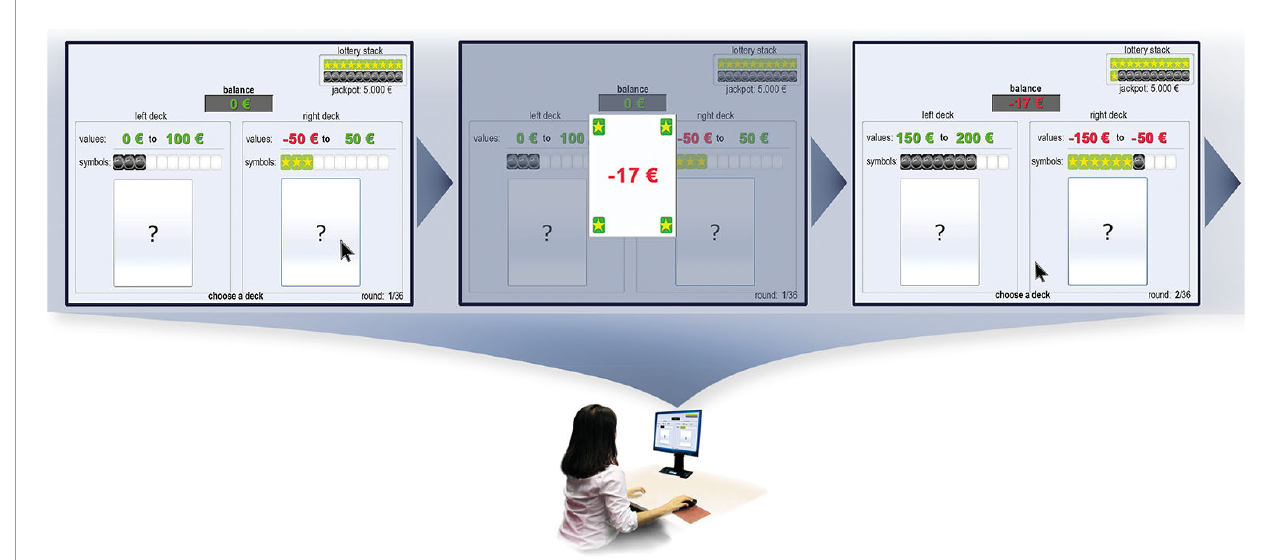
FIGURE 1 | Illustration of a decision-making situation in the Cards and Lottery Task. The task starts with a balance of 0 EUR and a lottery stack of 10 stars versus 10 bombs. The left deck contains 10 cards with immediate gains ranging from 0 to 100 EUR, of which three additionally have bomb symbols and seven are neutral. The right deck contains 10 cards with values ranging from − 50 EUR to 50 EUR, of which three additionally have star symbols and seven are neutral. In this example, the participant draws a card from the right deck. Feedback is immediately given about the card randomly drawn from the right deck, in this case a card with an immediate loss of − 17 EUR and a star symbol. Participant ’ s balance and lottery stack are updated according to the card drawn previously. The next trial starts with altered win/loss margin and star/bomb symbol frequencies displayed above both